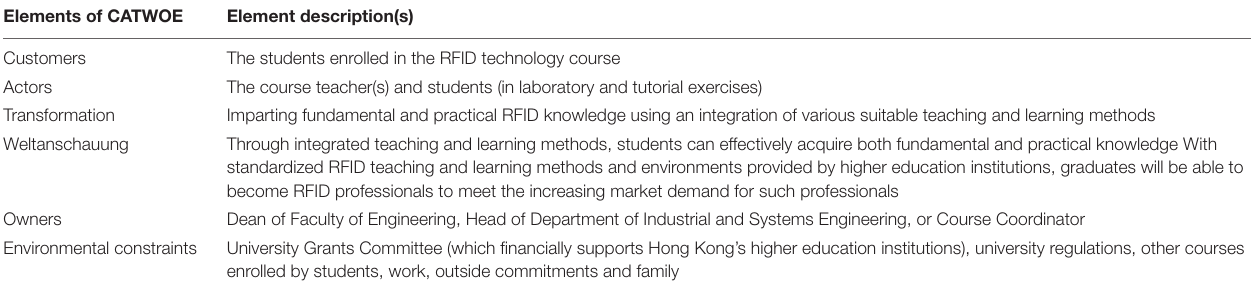
FIGURE 4 | A rich picture of RFID education. TABLE 7A | The root definition of the radio frequency identification education model. Elements of CATWOE